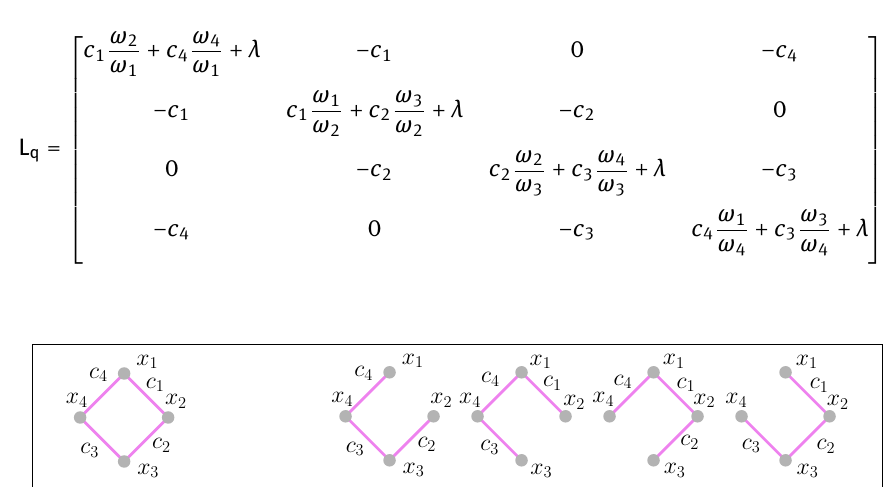
Figure 10: The network C 4 (left) and the collection of spanning trees for C 4 (right).